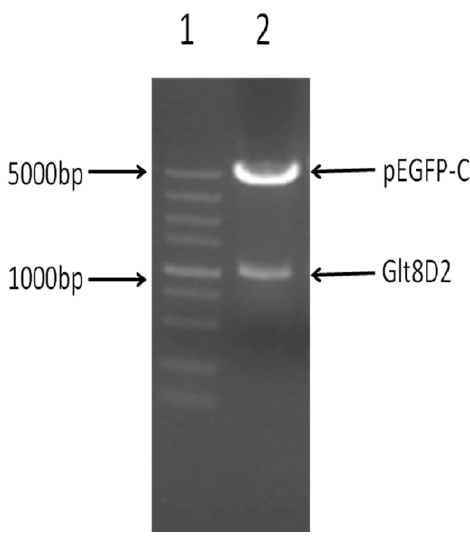
Figure 2. Electrophoresis of recombinant GLT8D2 on 1% agarose gel. Lane 1 : DNA marker; Lane 2 : Double digestion of recombinant pEGFP-C1-GLT8D2 with Kpn I and Xho I restriction enzymes (pEGFP-C1, 4700 bp and GLT8D2, 1050 bp).